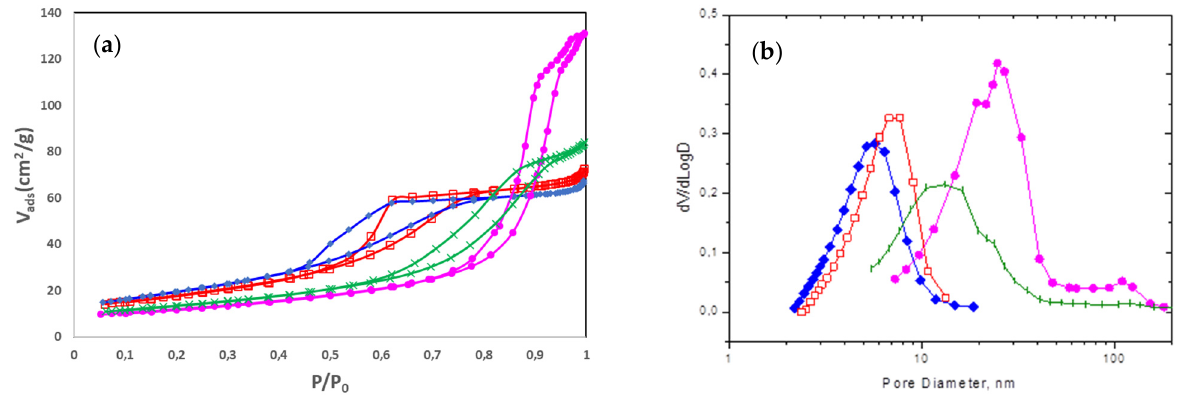
Figure 2. N 2 -physisorption isotherms of catalysts ( a ) and their pore size distributions ( b ): NiCe P (red squares); NiCe M (green cross); NiLaCe P (blue rhombs); NiLaCe M (violet circle). Table 1. Physico-chemical properties of the catalysts.